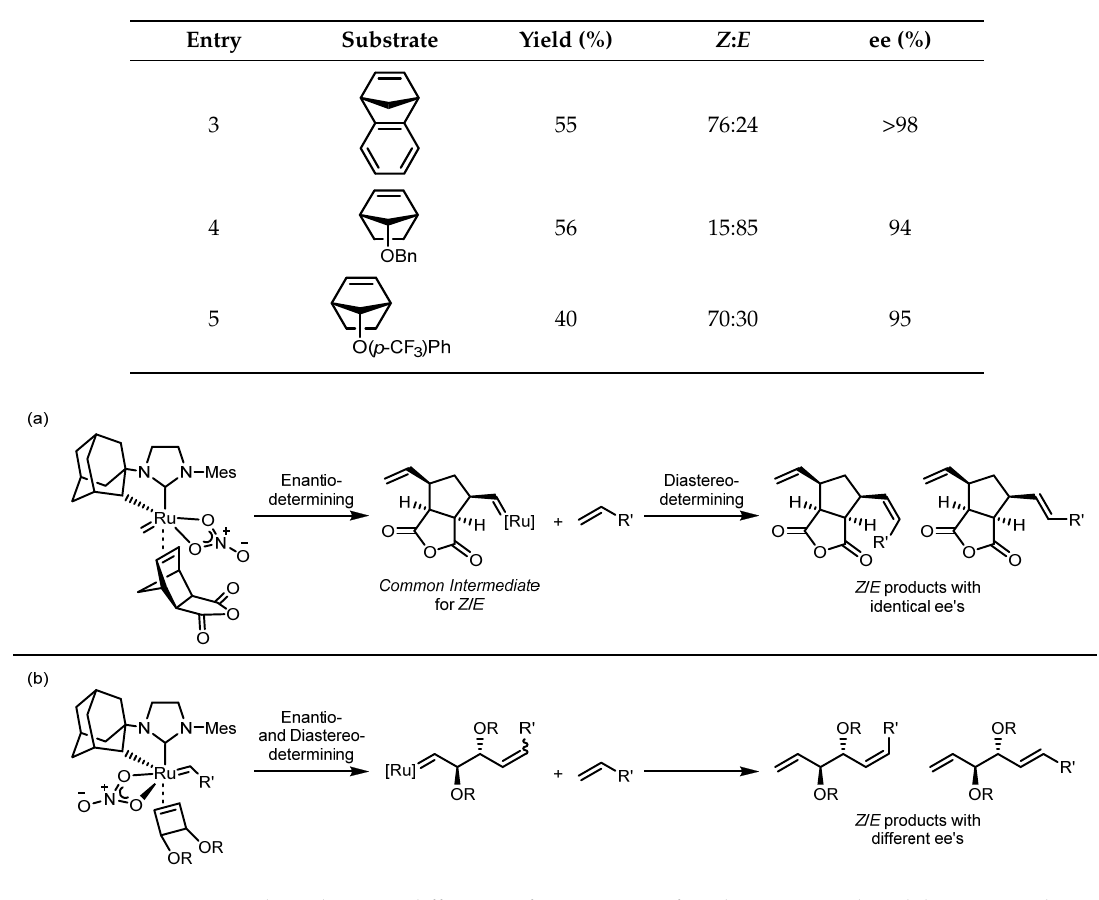
Figure 14. Proposed mechanistic differences for AROCM of norbornenes and cyclobutenes with terminal olefins. ( a ) Enantiodetermining step occurs before the diastereodetermining step; ( b ) Enantio- and diastereodetermining events occur in the same step. Further evaluating the scope of cyclobutenes led to the formation of various 1,2- anti -diols (Table 19), which can be derivatized to useful monosaccharides. Table 19. Z -Selective AROCM of cyclobutenes using ent - 6 .